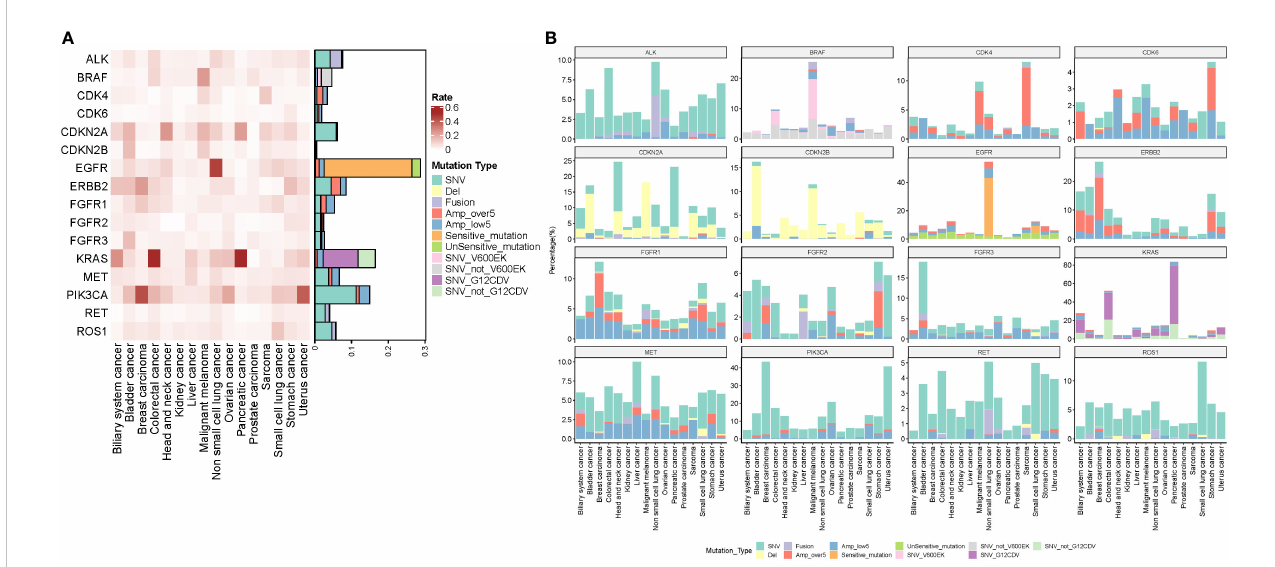
FIGURE 3 (A) Recurrent somatic alterations across common tumor types. According to the targeted drug, gene ampli fi cations were divided into high-level (copy number of >5) and low-level (copy number of <5) ampli fi cations. EGFR mutations were divided into sensitive and insensitive mutations. BRAF mutations were divided into BRAF V600E/K and non- BRAF V600E/K mutations. KRAS mutations were divided into KRAS G12C/D/V and non- G12C/D/E mutations. (B) The frequency of the druggable gene alterations in 17,841 pan-cancer patients across 16 common tumor types including ALK , BRAF, BRCA1/2, CDK